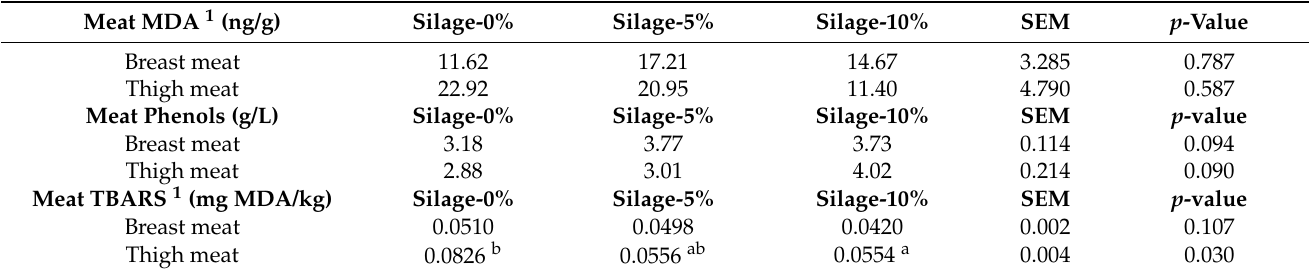
Table 8. Effect of silage supplementation on broiler breast and thigh meat oxidative